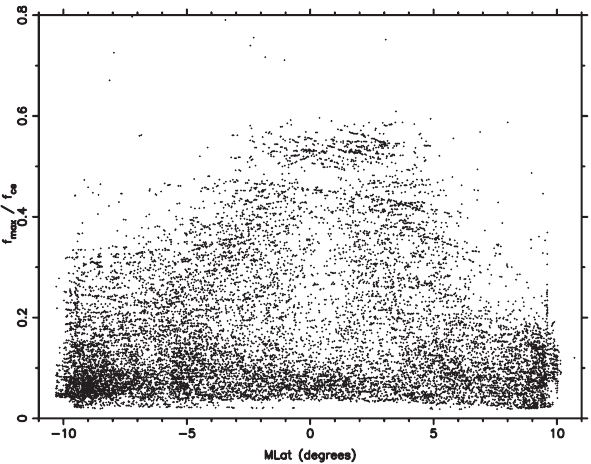
Fig. 8. A plot of the upper cutoff of the chorus frequency normal- ized to f ce versus magnetic latitude. Each point represents a value obtained from an algorithm that analyzed each frequency sweep of data within the chorus emission frequency range. The highest fre- quency of emission above a threshold power spectral density was recorded. Most outliers represent noise and electrostatic emissions (not